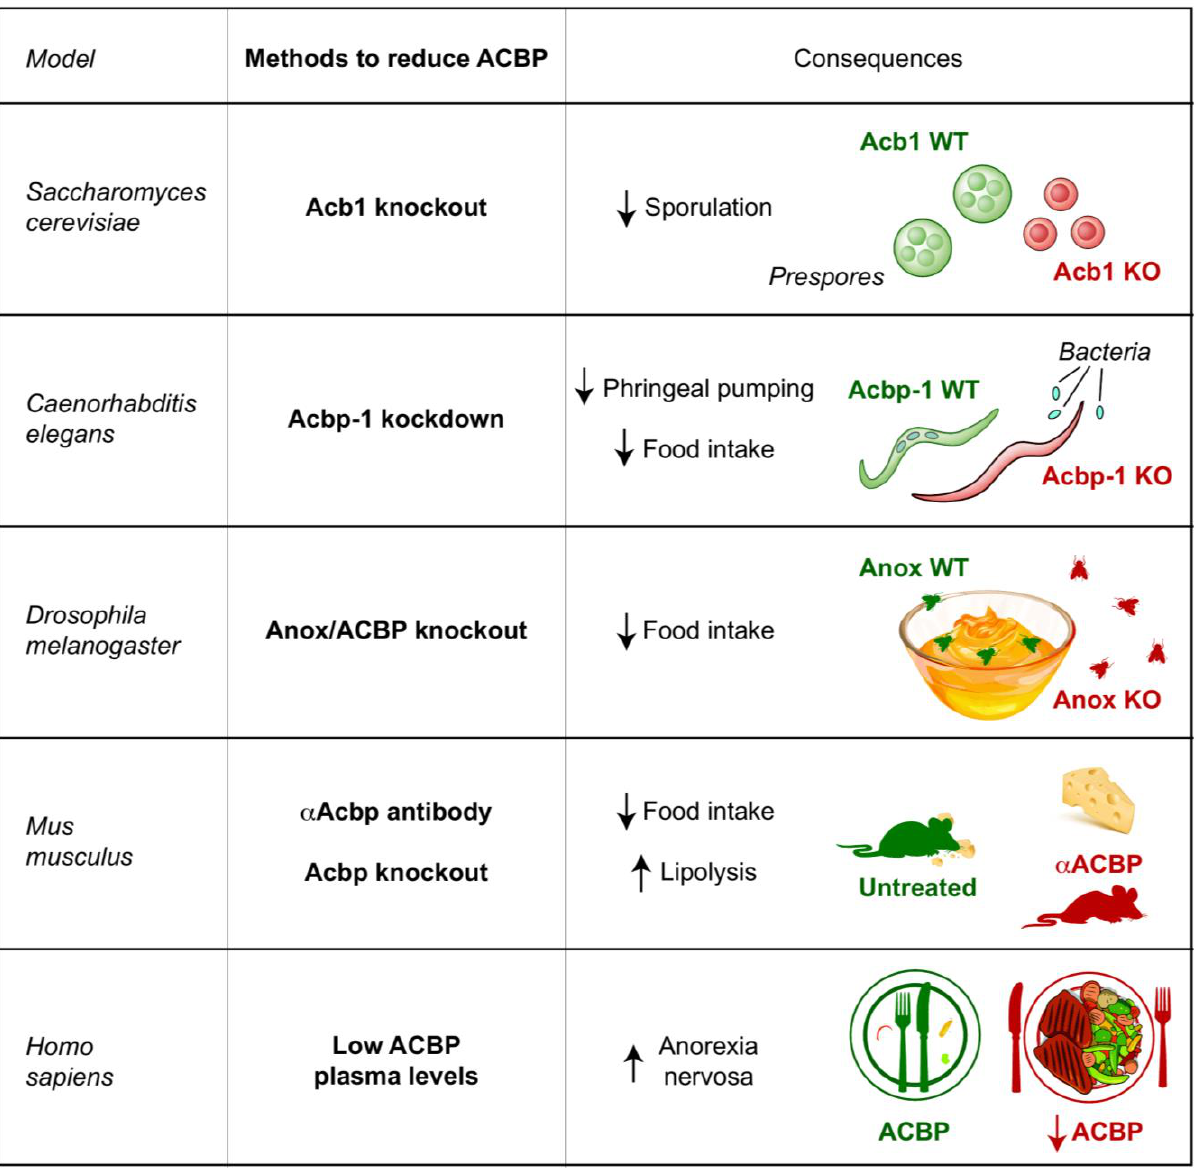
FIGURE 1: Main consequences of neutralization/removal of ACBP/DBI in yeast ( Saccharomyces cerevisiae ), worms ( Caenorhabditis ele- gans ), flies ( Drosophila melanogaster ), mouse ( Mus musculus ) and human ( Homo sapiens